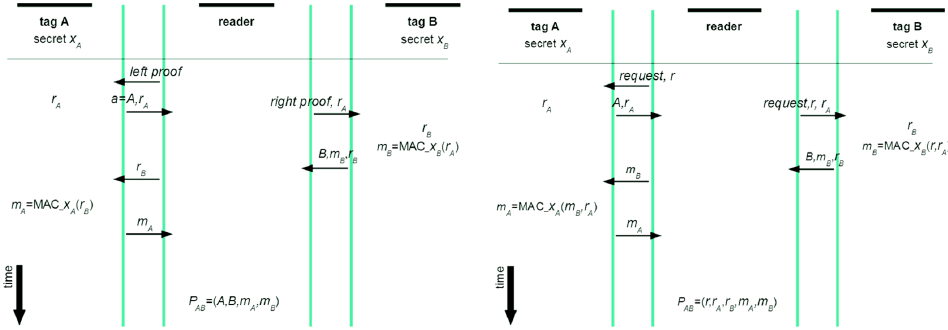
Figure 2. Juels’ Yoking proof protocol ( Left ), and Piramuthu’s extension of Juels’ protocol ( Right ).